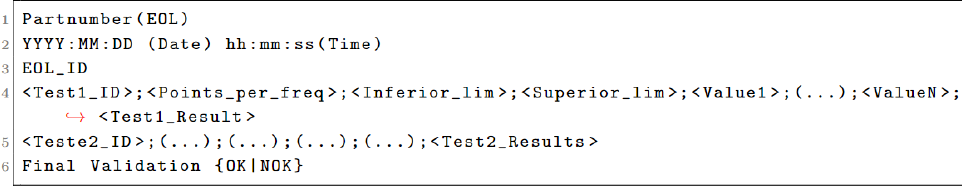
Figure 1. Text file